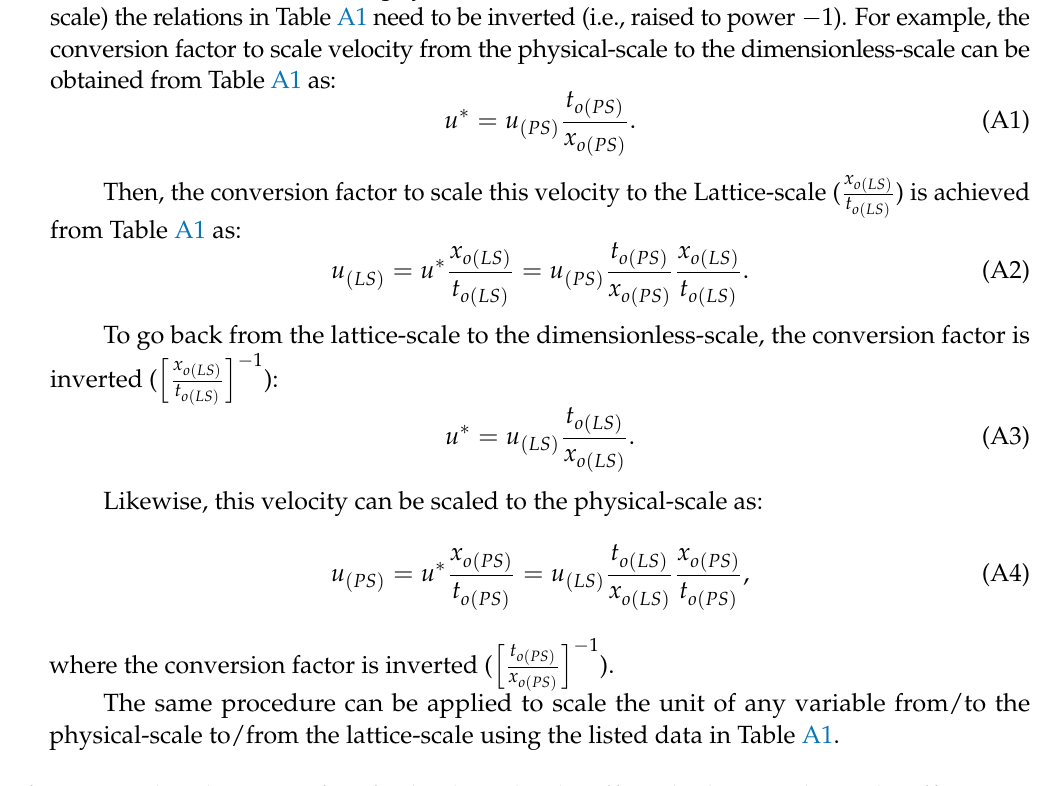
Converting Factor from Physical-Scale to Dimensionless-Scale